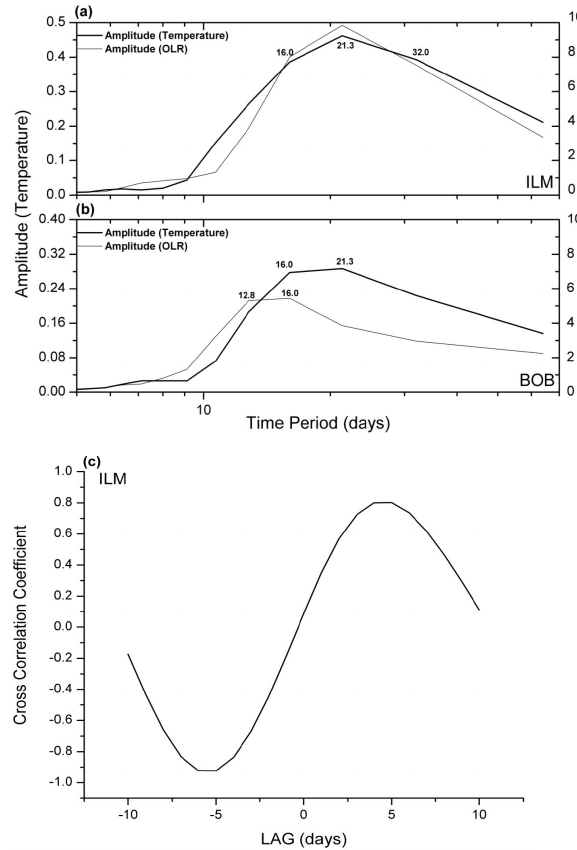
Figure 7. Fig. 7. Spectrum of OLR and T 100 anomaly time series over ILM BOB regions, after passing through a band pass filter of 13– 18 days period, are shown in panel (a) and (b) , respectively and panel (c) shows cross correlation function between T 100 and OLR time series over ILM